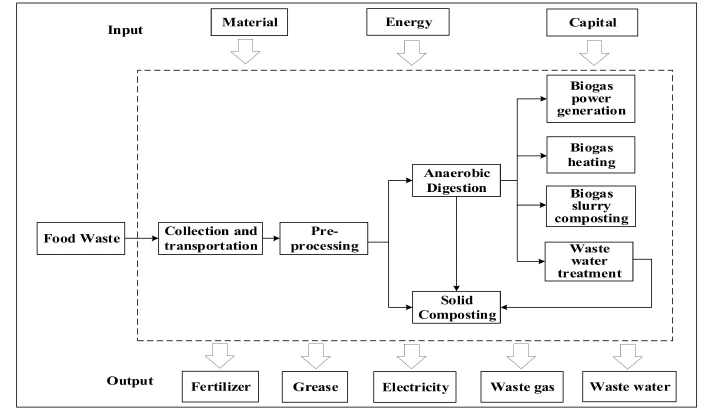
Figure 1. System boundaries of life cycle of restaurant food